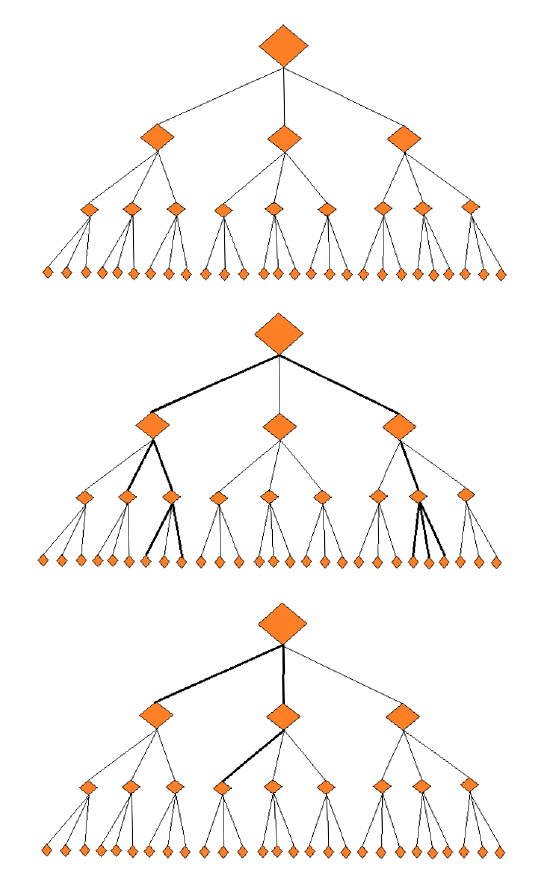
Figure 2. A Tree Network of an Epidemic